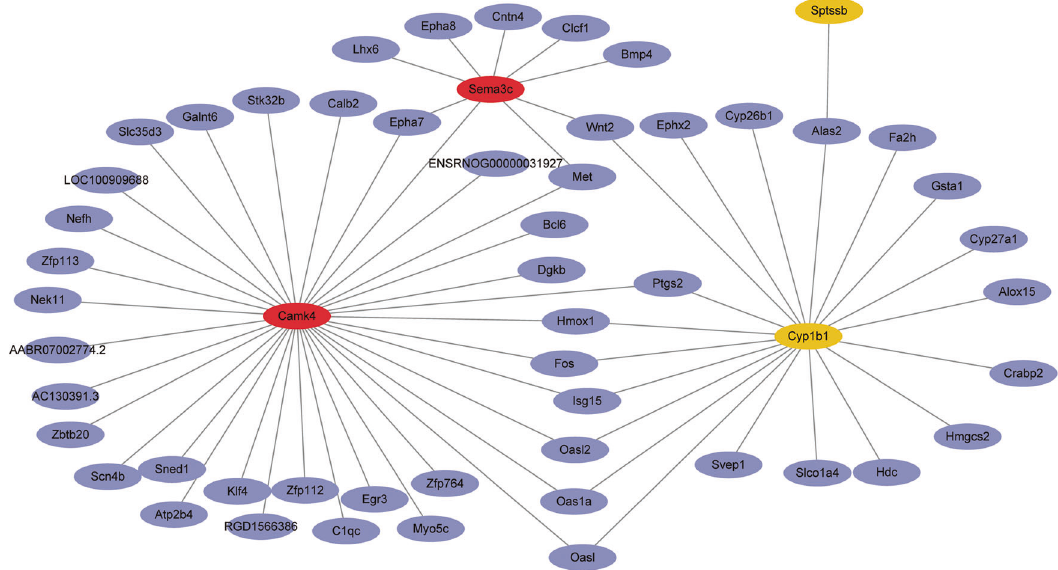
Fig. 3 Gene network mediating dendritic spines de fi ciency in hippocampus of CH rat pups. A gene network was constructed using the Ingenuity Pathway Analysis Software (IPA) based on DEGs at PN1, PN7, and PN21.